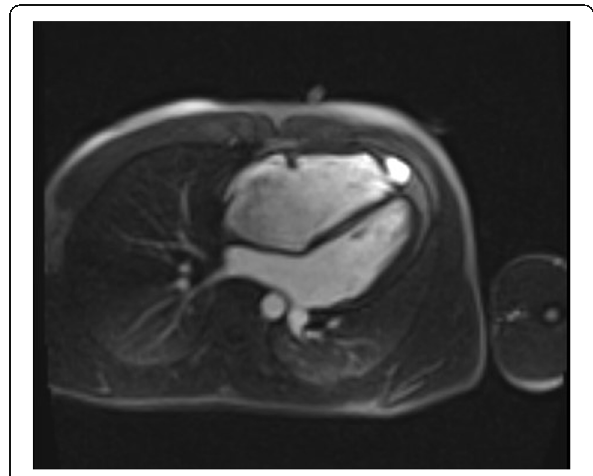
Fig. 4 Post-contrast four-chamber gated-MRI shows a small outpouching from the right ventricle apex into the pericardial space, connected through a small neck to the